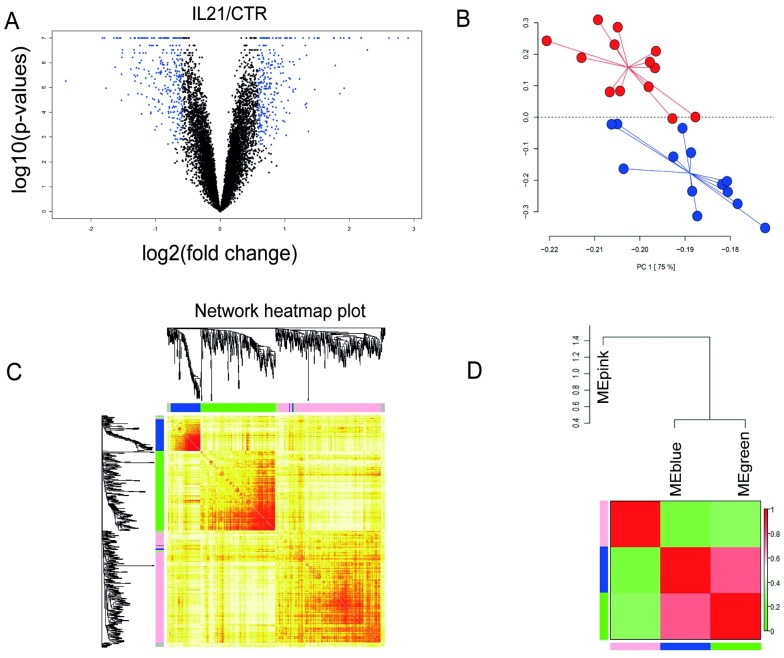
Bioinformatic analyses of IL21-modulated genes in activated CLL cells.(a) Volcano plot for the 12,166 genes detected by microarray analysis. The X-axis represents the fold-change, and the Y-axis represents the −log10
p value. A total of 582 probes (blue dots) were expressed differentially in IL21-treated, relative to untreated CLL cells, imposing an FDR < 0.01 and a fold-change > 1.5 or < 0.667. Global test: probability of obtaining at least 582 probes significant by chance if there were no real differences between the classes; p = 0.026. (b) The differentially expressed genes, as visualized by PCA, separated the samples in two well-defined groups corresponding to IL21-treated (blue) and untreated (red) cells. (c) WGCNA was performed on differentially expressed genes; clusters of like-regulated genes were referred to as modules by color (pink, green and blue). Those few genes (19) not included in the modules are in grey. In the heatmap, the intensity of red coloring indicates a high correlation of expression. (d) Eigengene dendogram and heatmap. Two correlated eigengenes, corresponding to MEgreen and MEblue, clustered together and differed from MEpink.